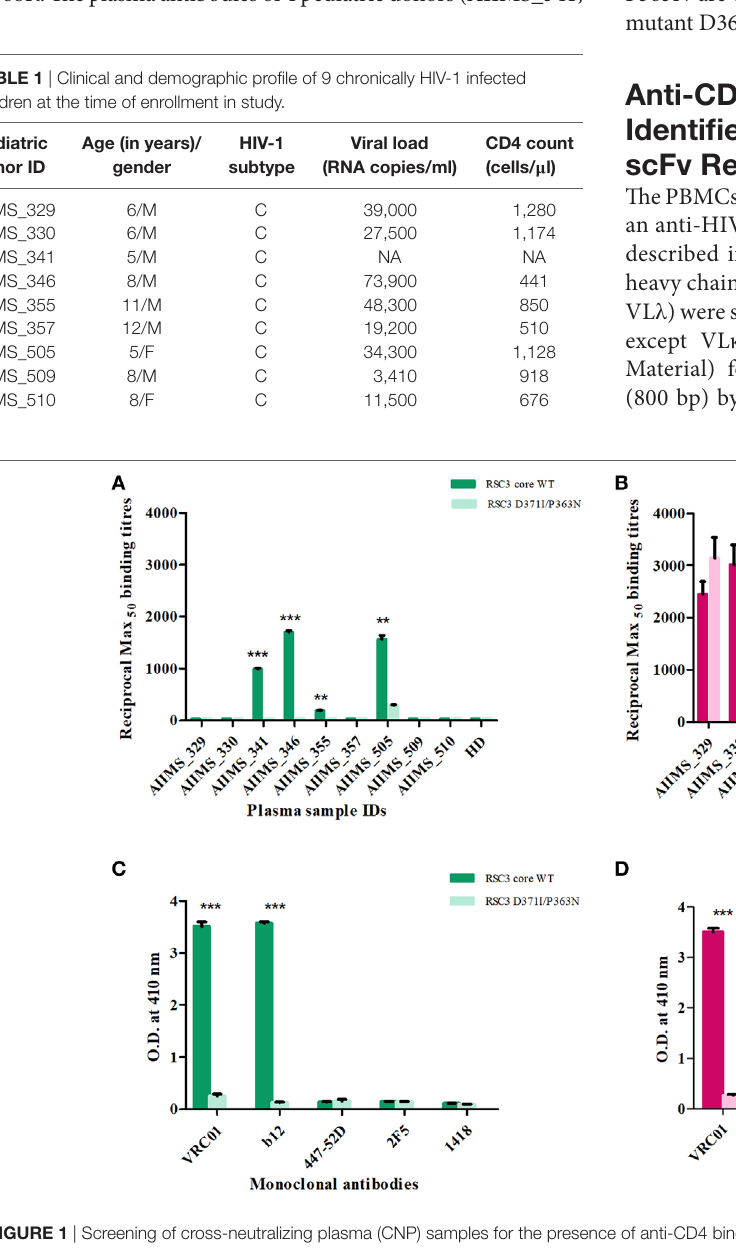
FigUre 1 | Screening of cross-neutralizing plasma (CNP) samples for the presence of anti-CD4 binding site (CD4bs) antibodies. (a) Nine CNP samples were tested for the presence of anti-CD4bs antibodies using CD4bs specific probes RSC3 core wild-type (WT) and its mutant Δ 371I/P363N at 2 µg/ml. (B) CNP samples were further tested for the presence of anti-CD4bs antibodies using HXBc2 WT and its mutant HXBc2 D368R gp120. Reciprocal Max50 binding titers were calculated using the least square regression method. The ELISA was repeated twice in triplicates. HD was the plasma of one healthy seronegative donor used as negative control. Mean reciprocal Max 50 binding titers were compared using unpaired t -test for each plasma sample for RSC3 core WT and its mutant or HXBc2 WT and its mutant D368R. P values < 0.05 were considered significant and shown by asterisk (*) symbol, (**) if p < 0.01 and (***) if p < 0.001. (c) The binding of RSC3 core WT and its mutant Δ 371I/P363N was checked with anti-CD4bs mAb VRC01 and b12 (positive controls) and anti-V3 mAb 447-52D, anti-MPER mAb 2F5 and anti-Parvovirus mAb 1418 were used as negative controls. (D) The binding of HXB2 gp120 WT and its D368R mutant was tested with